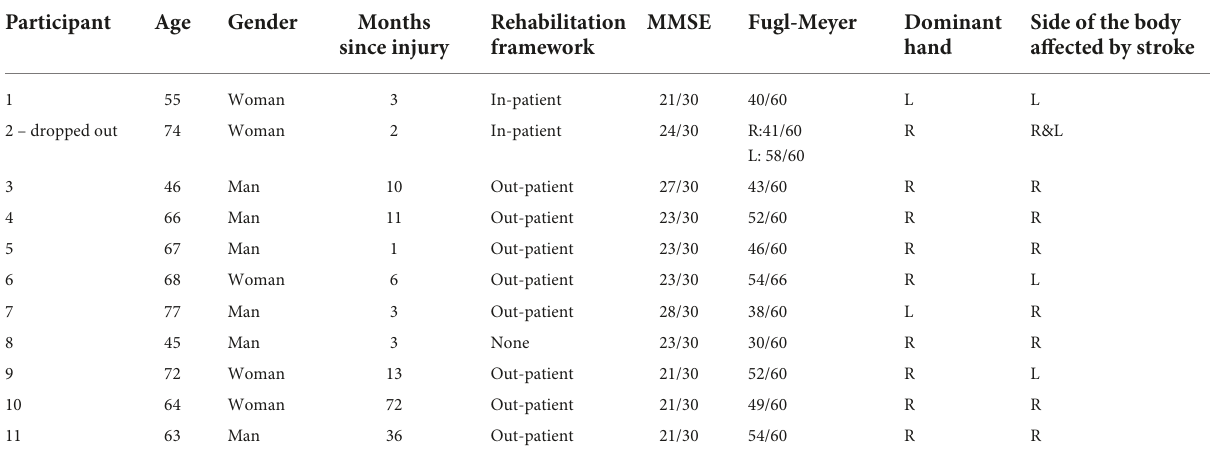
TABLE 4 Demographic characteristics of the